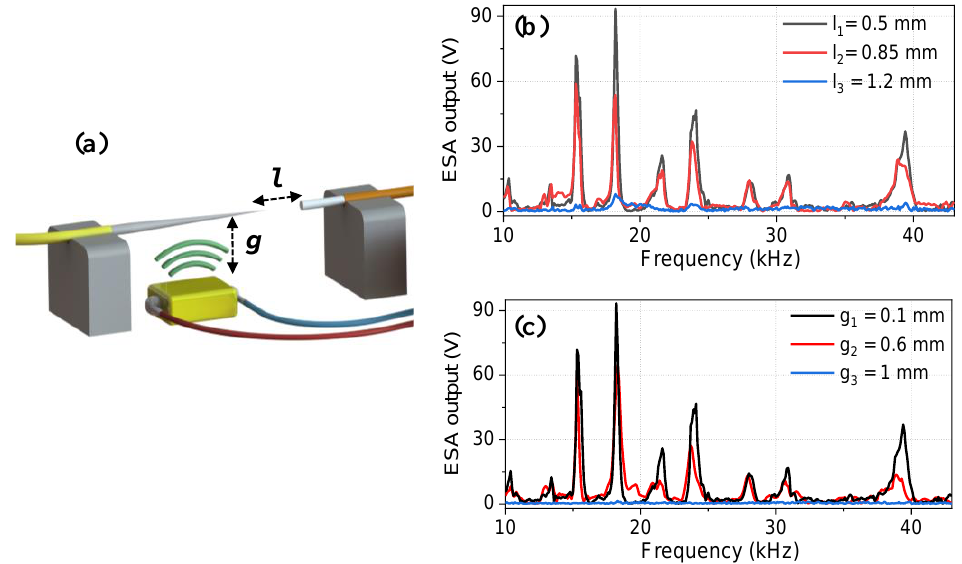
Figure 7. ( a ) Schematic indicating the parameters l and g . The effect of distance between ( b ) the tapered-tip fiber and the multimode fiber for three different values, and ( c ) the tapered-tip fiber and the piezo transducer for three different values on the frequency spectrum of the tapered-tip sensors. As can be seen, the frequencies of the resonances stayed the same but their amplitudes decreased with an increasing distance in both cases. Measurements were taken with tapered-tip fiber with a tip diameter of d t = 1.8 µm.